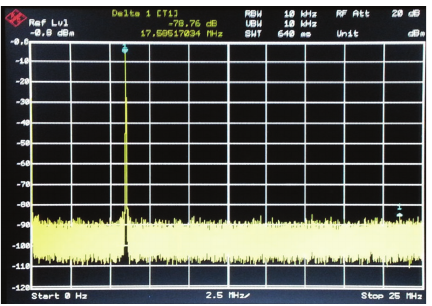
Figure 19: Spectrum of DDFS for FIW = 3998, DAC resolution = 14bits, and clock frequency = 50 MHz.